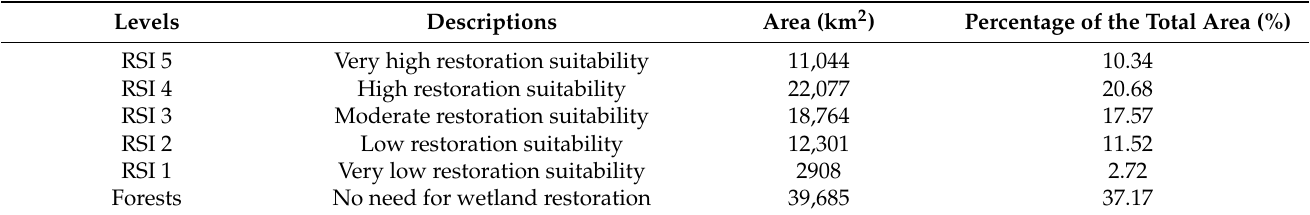
Table 2. Area and proportion of wetland restoration suitability of different